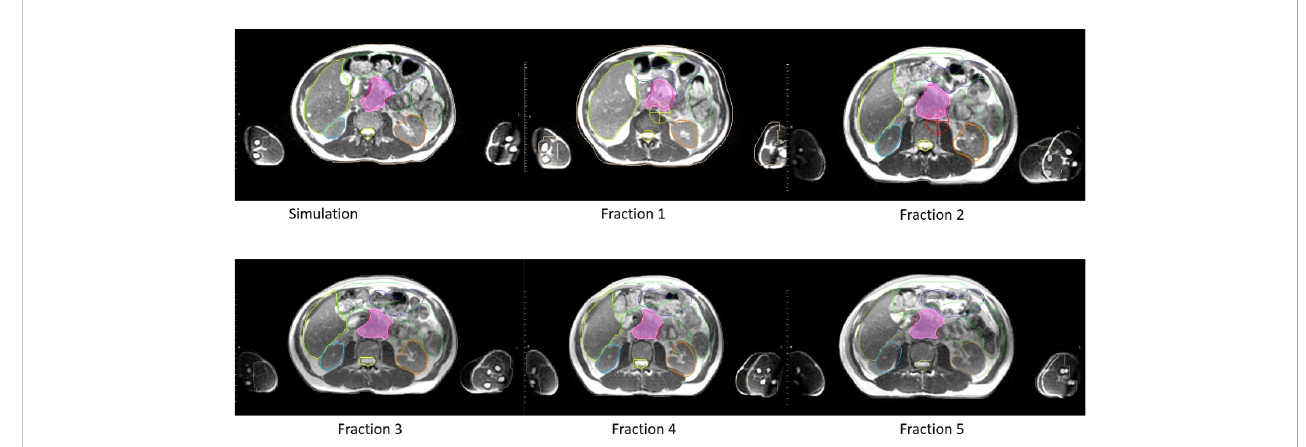
FIGURE 2 An example of clinical MRI-Linac images utilized for inter-fractional management. Comparison of anatomy seen on the day of simulation (upper left panel) and days of treatment (panels labeled Fractions 1 to 5 respectively) for a pancreatic cancer patient treated at our institution. In each panel, the target volume, stomach, and bowel anatomy are